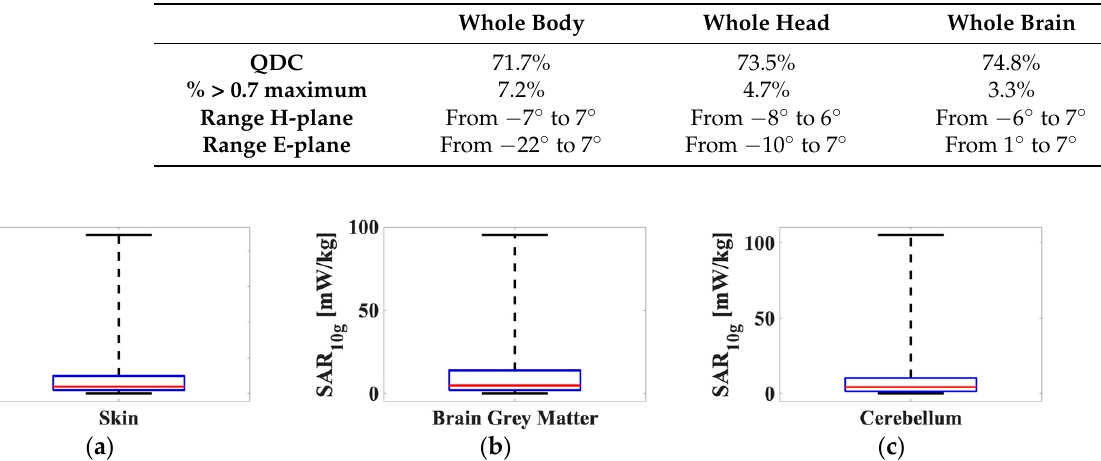
Figure 6. Boxplots of the maximum SAR values mediated on 10 g obtained for 1000 combination of the two input scan angles ( a ) on the skin, ( b ) on the brain grey matter, and ( c ) on the cerebellum. The lower and upper bounds of the boxes represent the first and the third quartiles, the line is the median value, and the whiskers are the minimum and maximum values.